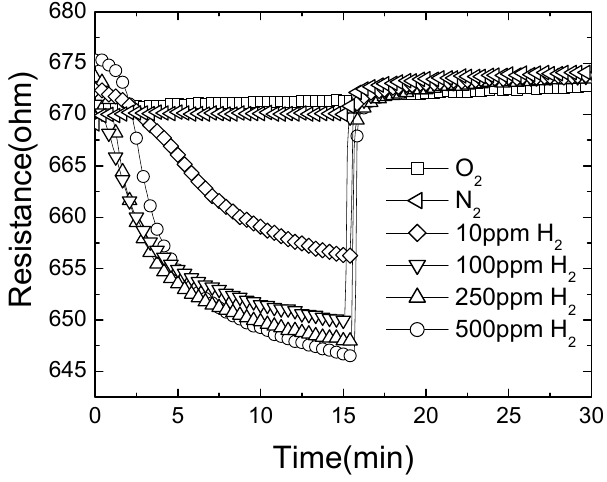
concentration in N 2